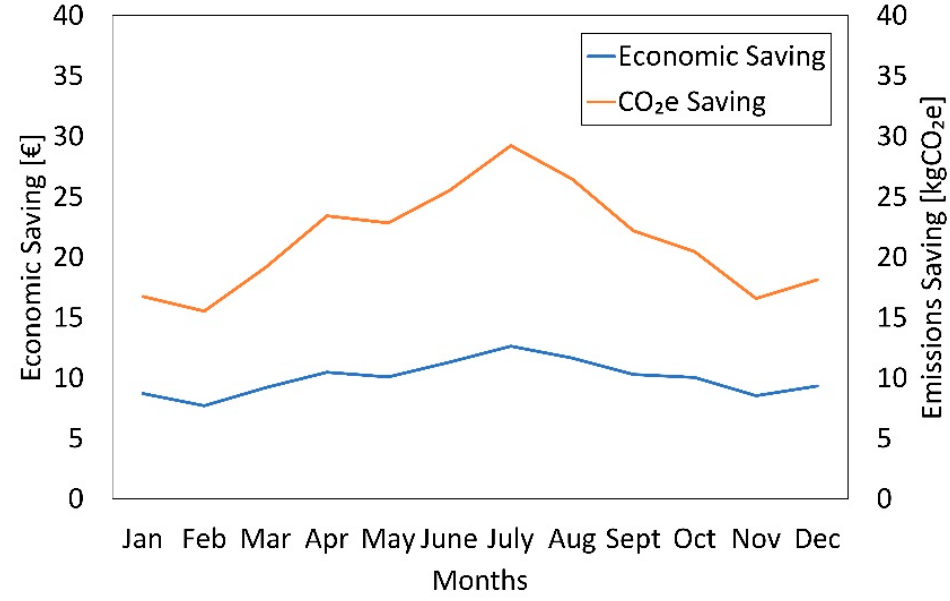
Figure 10. Monthly economic and CO 2 emissions savings provided considering single-delivery trips. The refrigerated van represents the reference solution without the PV panels installed.